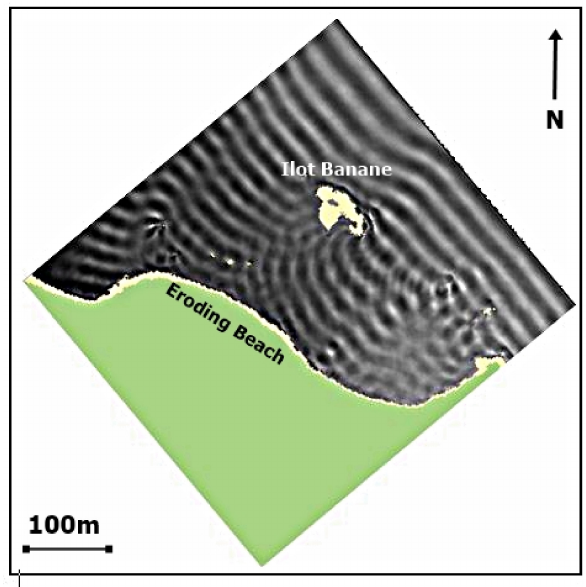
Figure 11. Modelled wave conditions at the site in the lee of Ilot Banane before reef